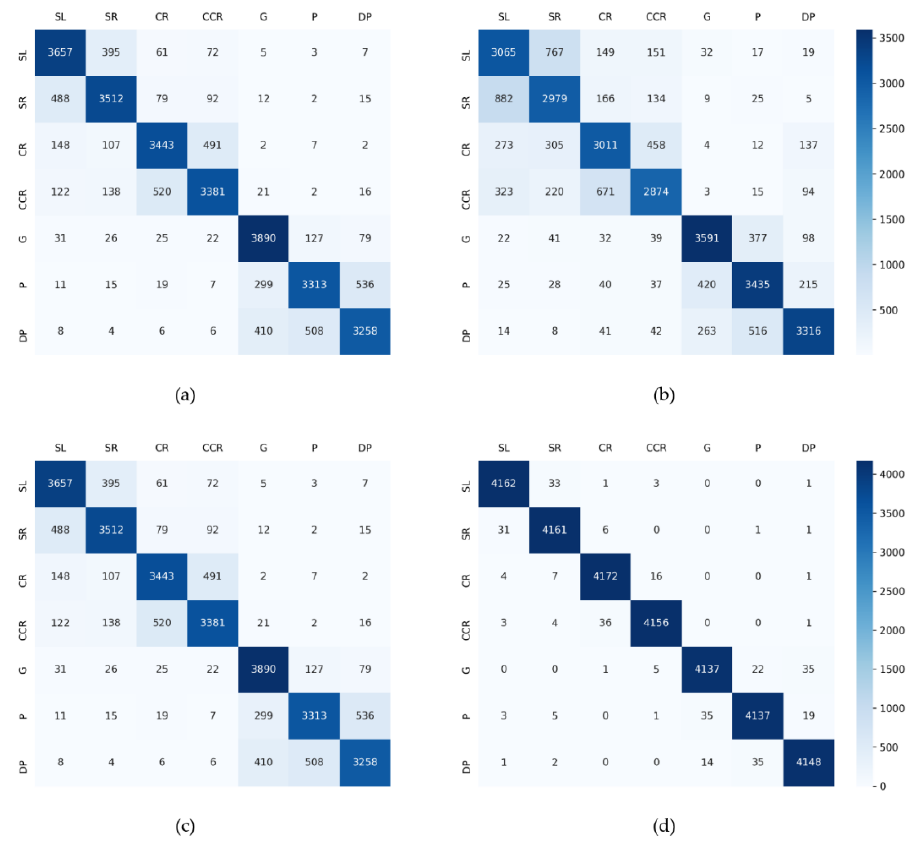
Figure 18. The gesture recognition accuracy of three system for new participants (target domain).